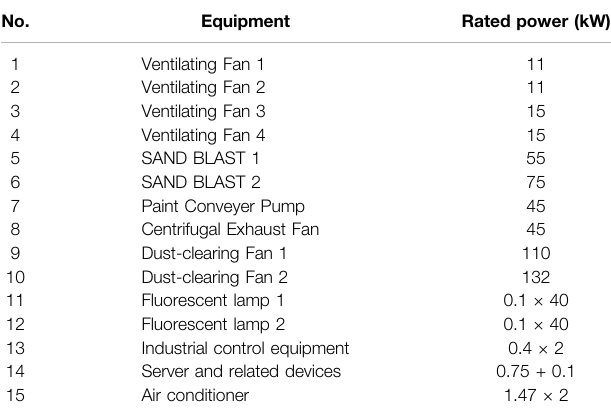
(cid:129) Figure 6 shows the simulation results for Scenario b) speci fi ed in Similar Motors.